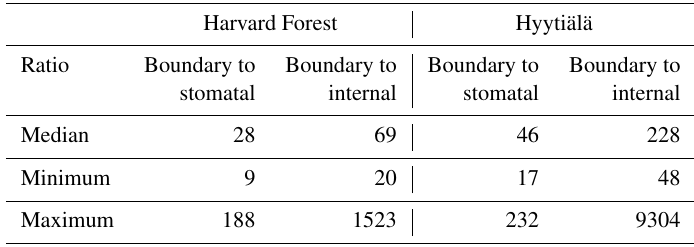
Table A1. Ratios of modelled boundary conductance to stomatal conductance and internal conductance at the two studied sites, computed over the year 2012 at Harvard Forest and 2017 at Hyytiälä.